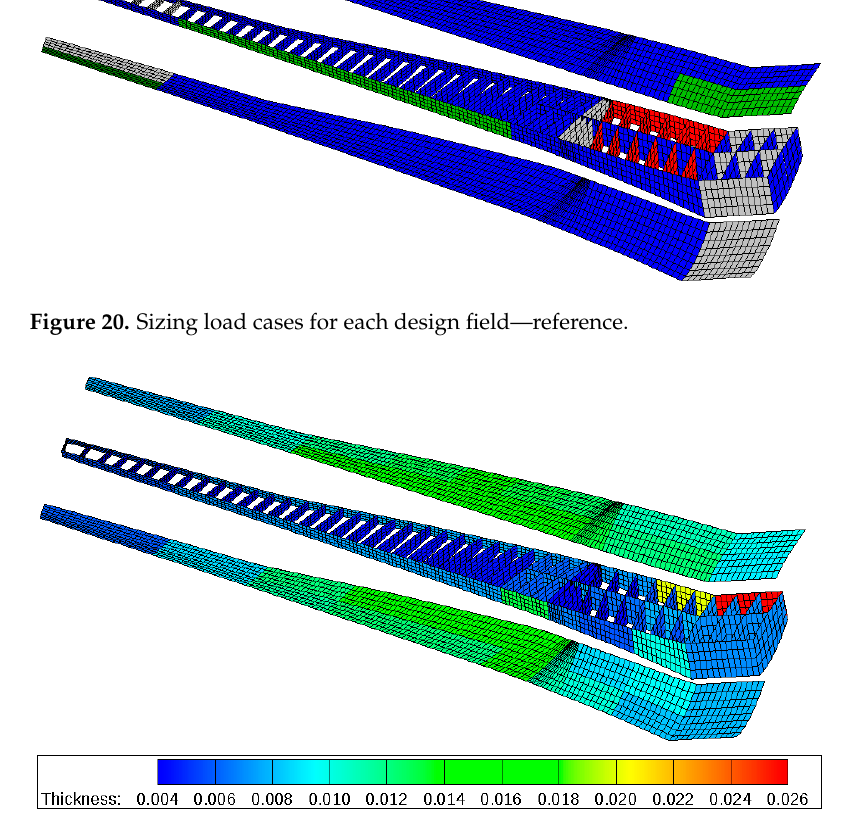
Figure 21. Material thickness distribution in m—reference.